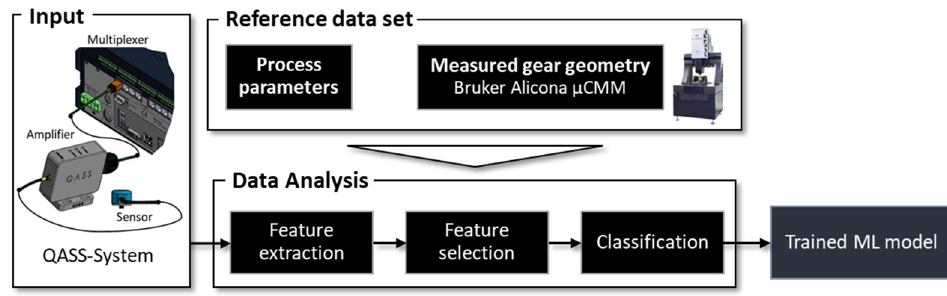
Figure 5. Data acquisition and analysis workflow [30,31].